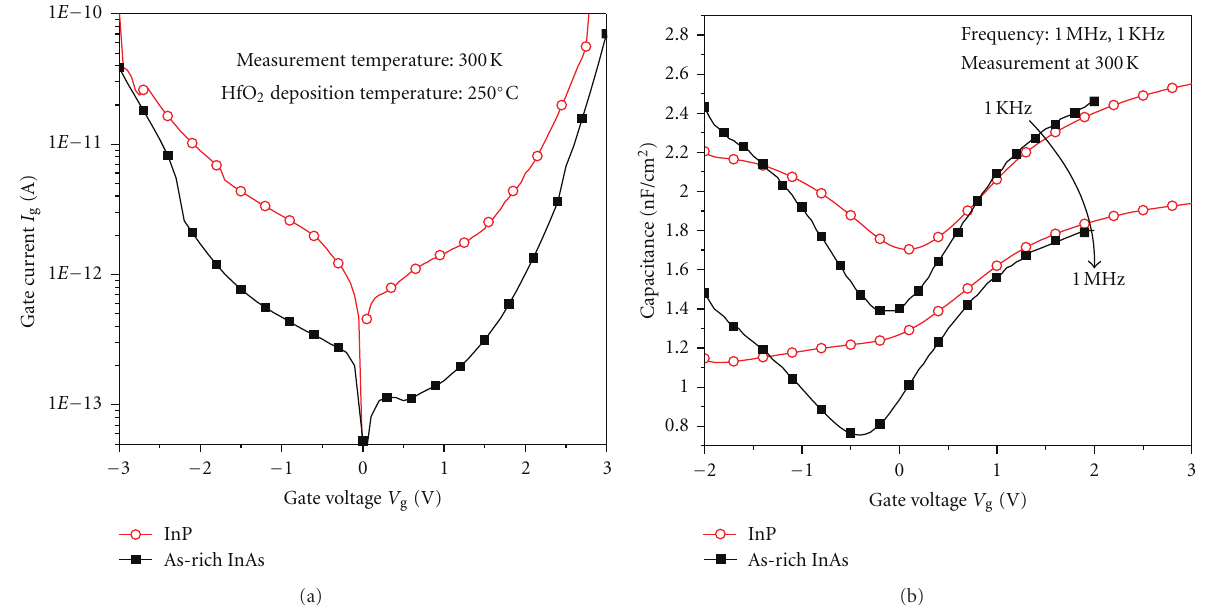
Figure 6: (a) I - V and (b) C - V characteristics of Pt/HfO 2 /InAs MOS capacitors with respective InP or As-rich InAs interfacial layers.